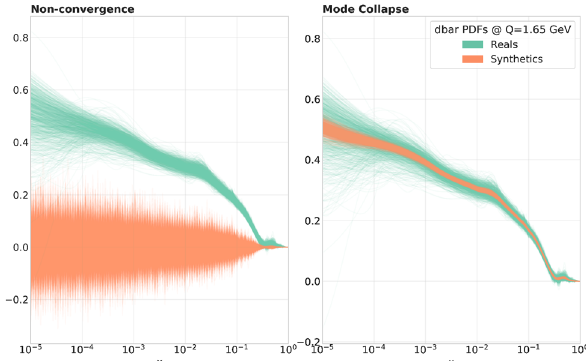
Fig. 1 Illustration of non-convergence and mode collapse in the con- text of Monte Carlo PDF replica generation. The two plots were gener- ated using Algorithm 1 but with different neural network